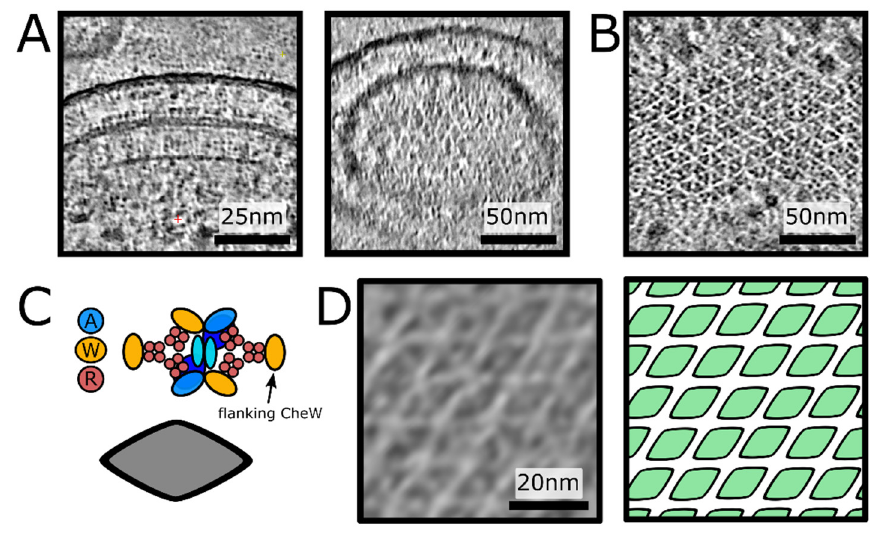
Figure 2. Direct visualisation of a p2 organisation of core-signalling units in an E. coli minicell strain. ( A ) 10nm thick oblique slices through a denoised tomogram with a chemoreceptor array aligned with the optical axis of the microscope. Scale bar 25 nm. ( B ) 10nm thick oblique slice through a denoised tomogram with a chemoreceptor array aligned perpendicular to the optical axis of the microscope. Scale bar 50 nm. ( C ) A schematic of the CSU (top) showing the positions of CheA (blue), CheW (yellow) and receptor proteins (red). A simplified visualisation of the CSU is shown as a grey diamond ( bottom ). ( D ) The chemoreceptor array from ( B ), depicted as a membranogram ( left ) following the curved surface of the array inside the cell, shows a p2 symmetric array of CSUs ( right ). The protein density in A, B and D is black. Scale bar 20 nm.